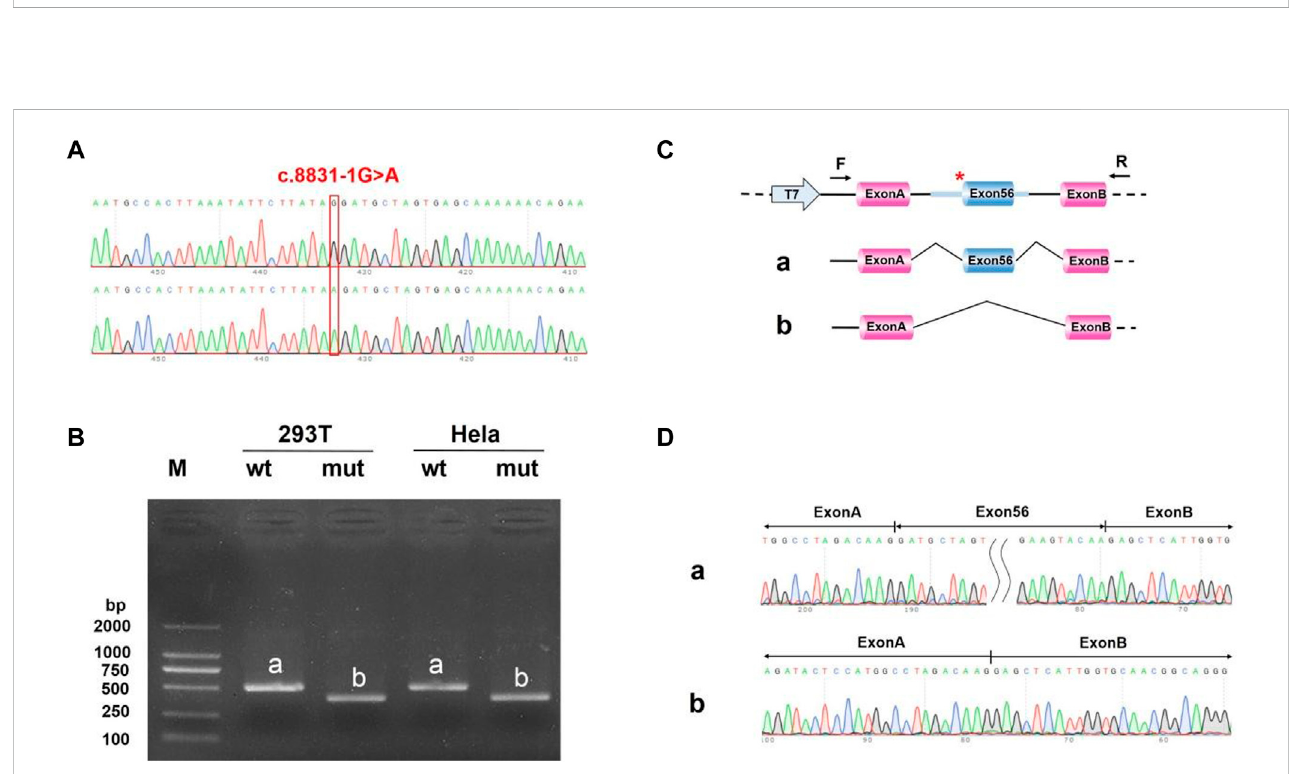
FIGURE 11 MinigeneanalysisbasedonpcMINI- DYNC2H1 -wt/mutrecombinantvector (A) Sangersequencingresultsoftherecombinantvector. (B) Electrophoresis results of transcript PCR products in both 293T and HeLa cell lines. (C) A schematic splicing mechanism of the DYNC2H1 c.8833-1G > A variant. (D) Sanger sequencing of PCR products. Red * indicates the mutation site.